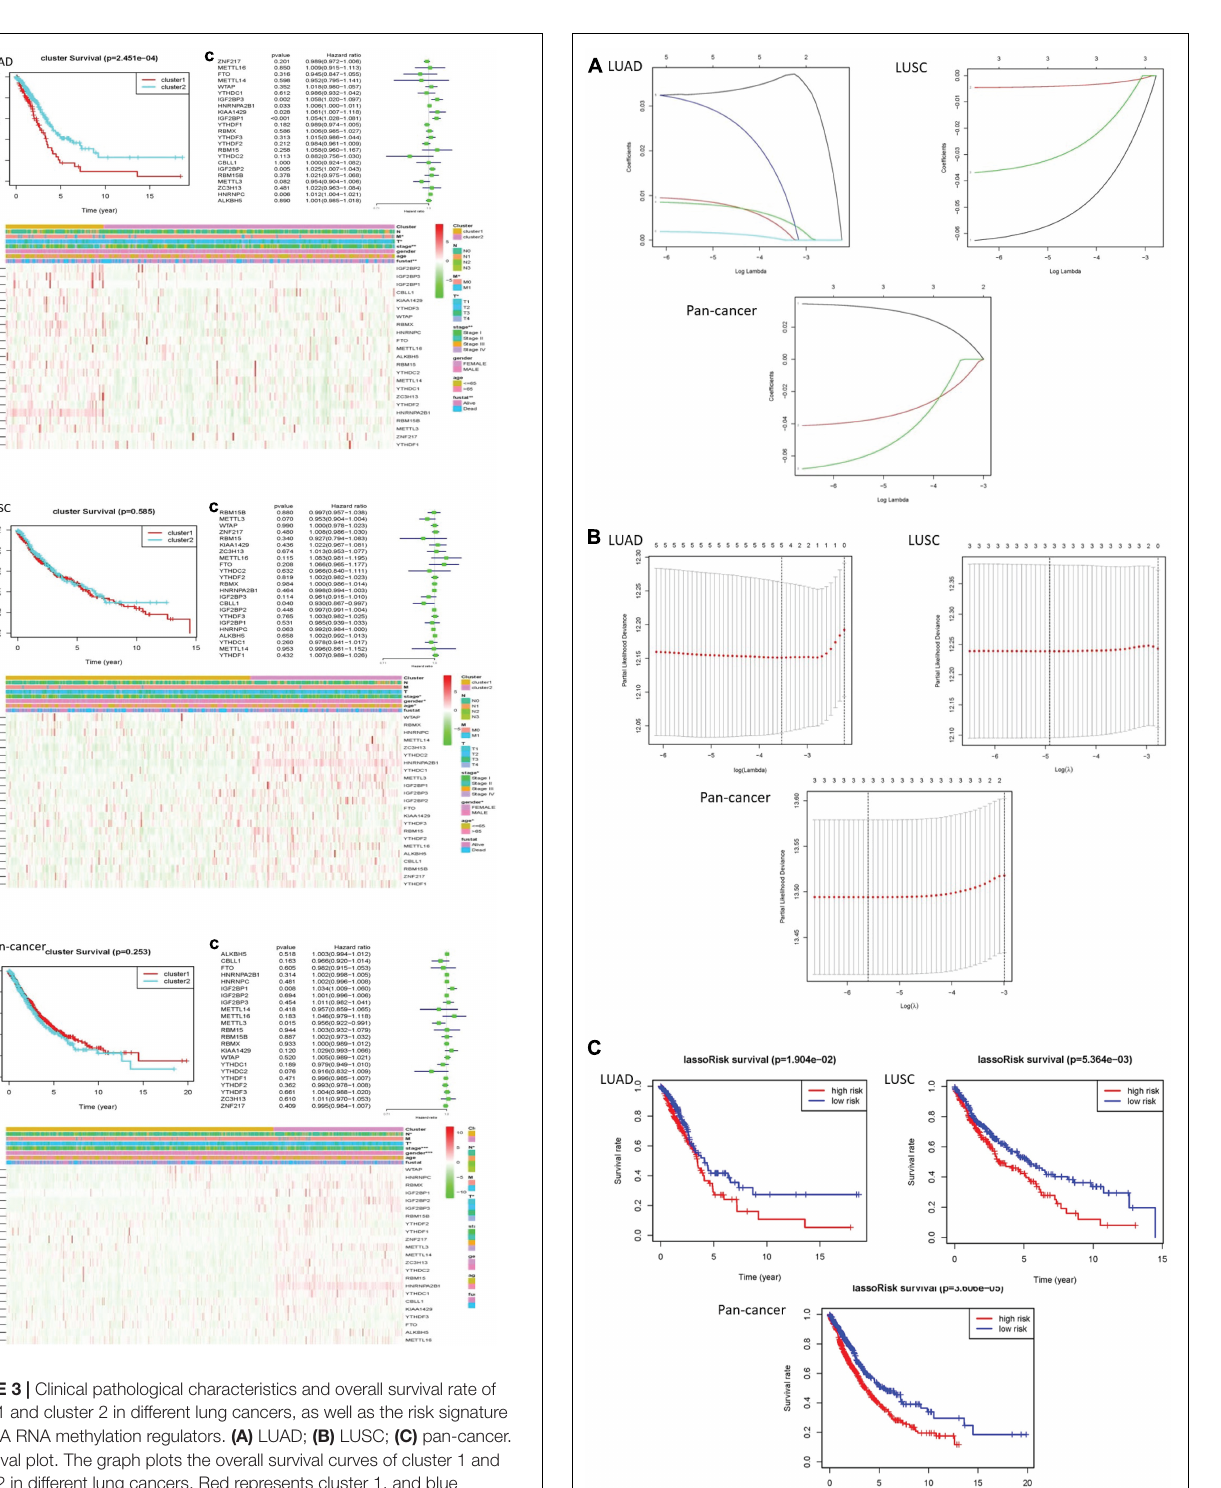
Frontiers in Cell and Developmental Biology | www.frontiersin.org